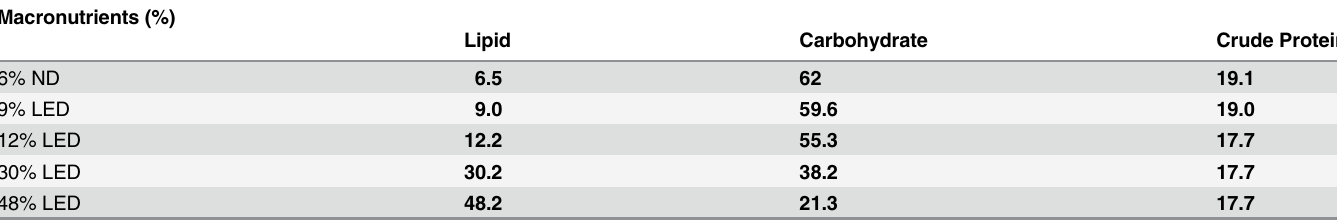
Table 1. Percentage of macronutrients for each specific normal diet (ND) and lipid-enriched diet